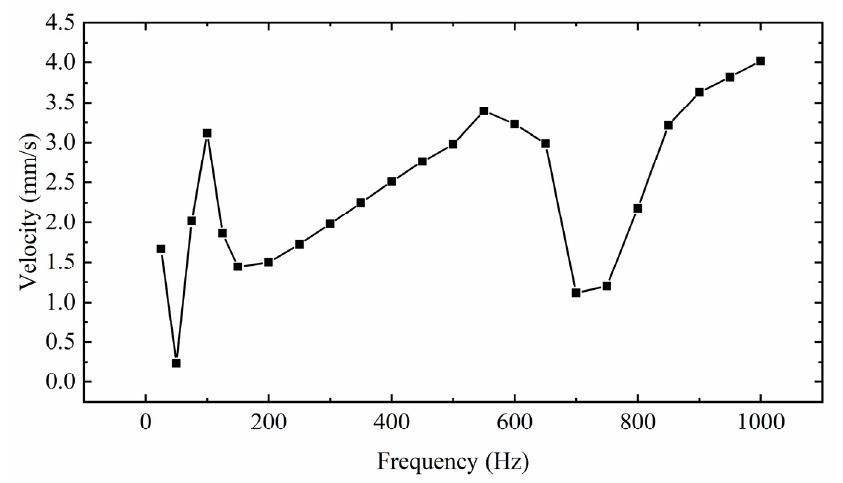
Figure 25. Relationship between the velocity of mover and excitation frequency.